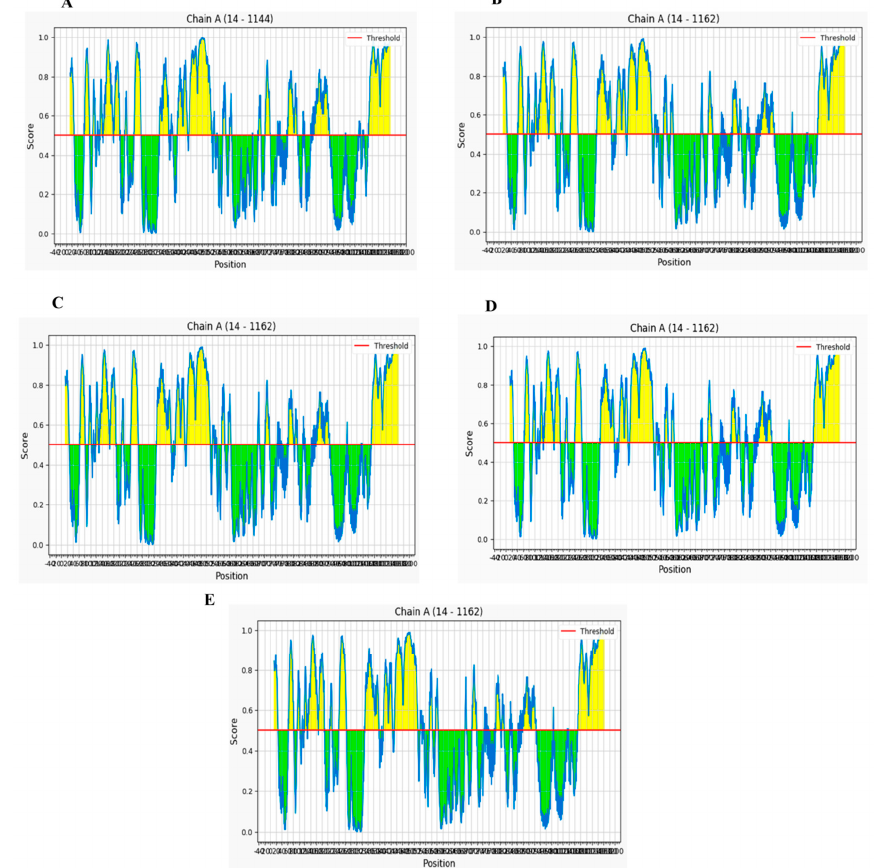
Figure 2. Graphical representation of B-cell linear epitopes of the spike protein of SARS-CoV-2 variants isolated from ( A ) Wuhan, China, ( B ) England, ( C ) USA, ( D ) India, and ( E ) South Africa predicted by Ellipro with a threshold of 0.5, wherein X axis represents sequence position number and Y axis represents Ellipro score. Sequences stretching between the positions 14 and 1162 harbor potential B-cell linear epitopes.